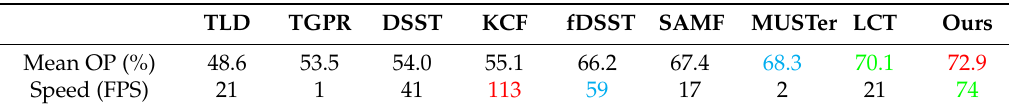
Table 1. Mean overlap precision (OP) scores and tracking speed on the OTB-2015. The first, second and third highest results are colored by red, green and blue.